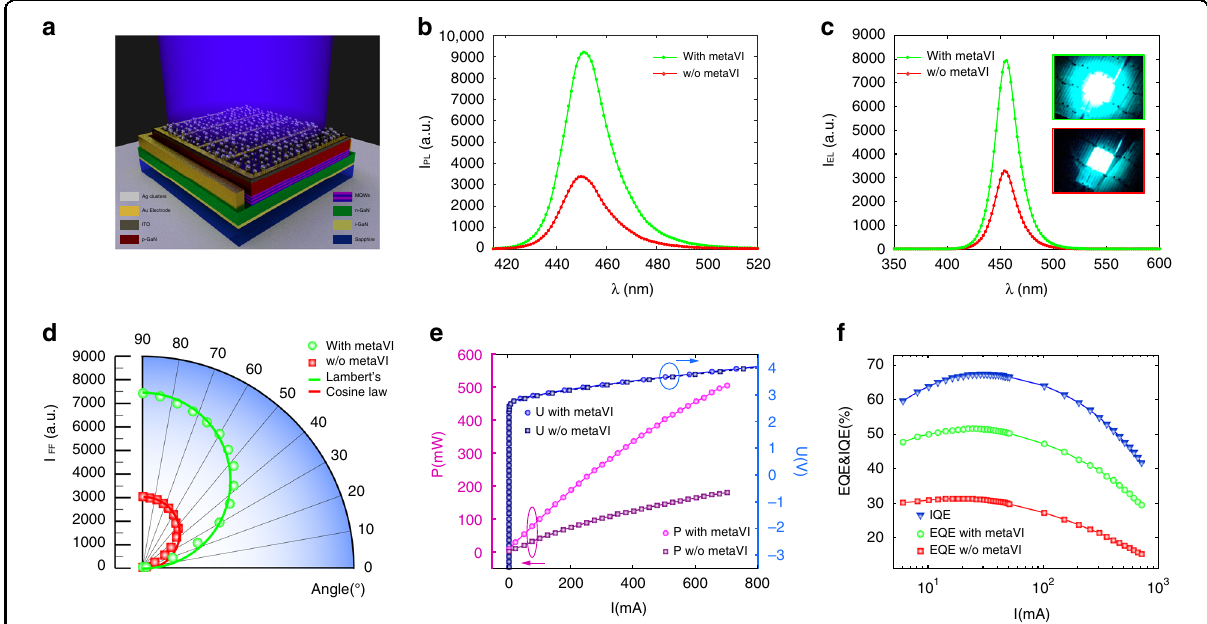
Fig. 4 Performance of commercialised LED with disordered metasurface Meat-IV. a Schematic illustration (not to scale) of a GaN-based LEDs with disordered metasurface deposited on the top. b Photoluminescence spectra of LEDs with/without Meat-IV, with an enhancement of 170%. c Electroluminescence spectra of LEDs with/without Meat-IV, with an enhancement of 140% d Polar plot for the far- fi eld light intensity of LEDs with/ without Meat-IV. The data is fi tted with Lambert ’ s cosine law for each case. e The voltage and output power as a function of current for LEDs with/ without Meat-IV. The metasurface has negligible impact on light generation of the LED beneath (from I-U) but prominent impact on light extraction (from I-P). f IQE and EQE of LEDs with/without Meat-IV. After packaging, the EQE is increased from 31.6% to 51.5% by aid of